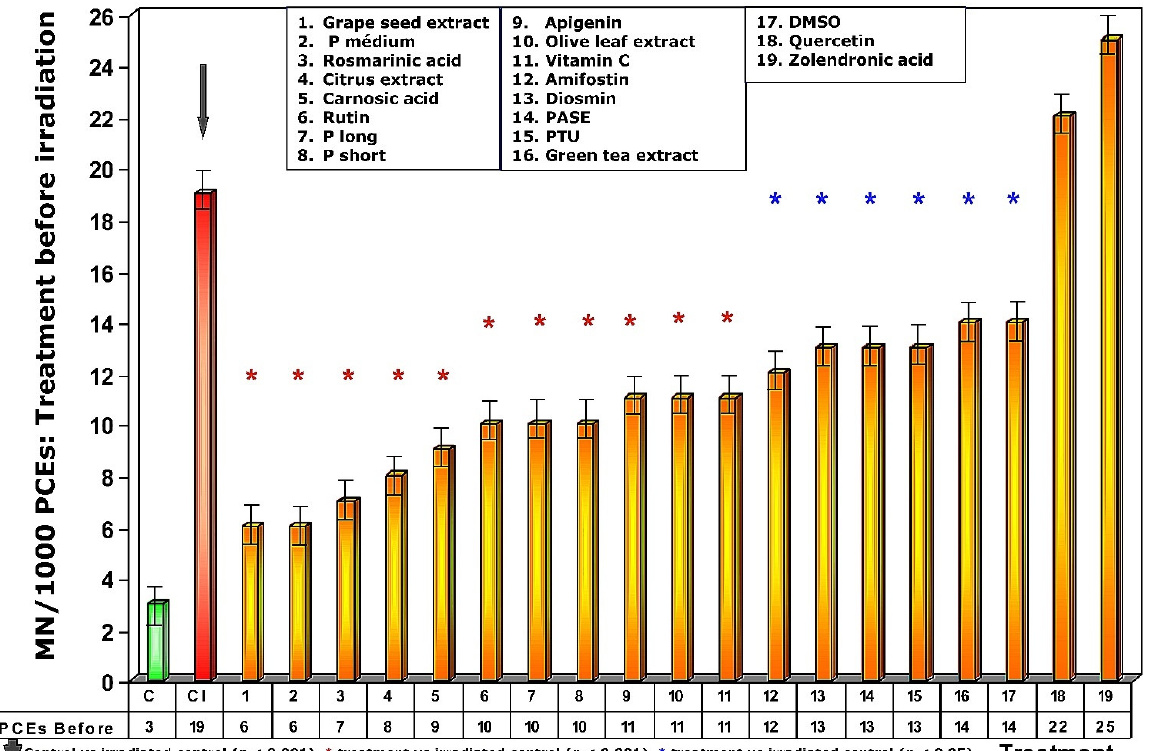
Figure 3. Frequency of micronuclei in polychromatic erythrocytes treated with test substances immediately before exposure to ionizing radiation.